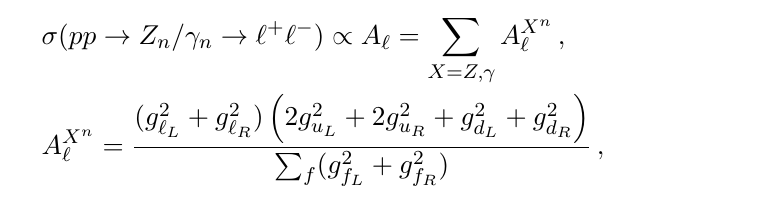
Z n =(cid:13) n ‘ + ‘ (cid:0) ! !